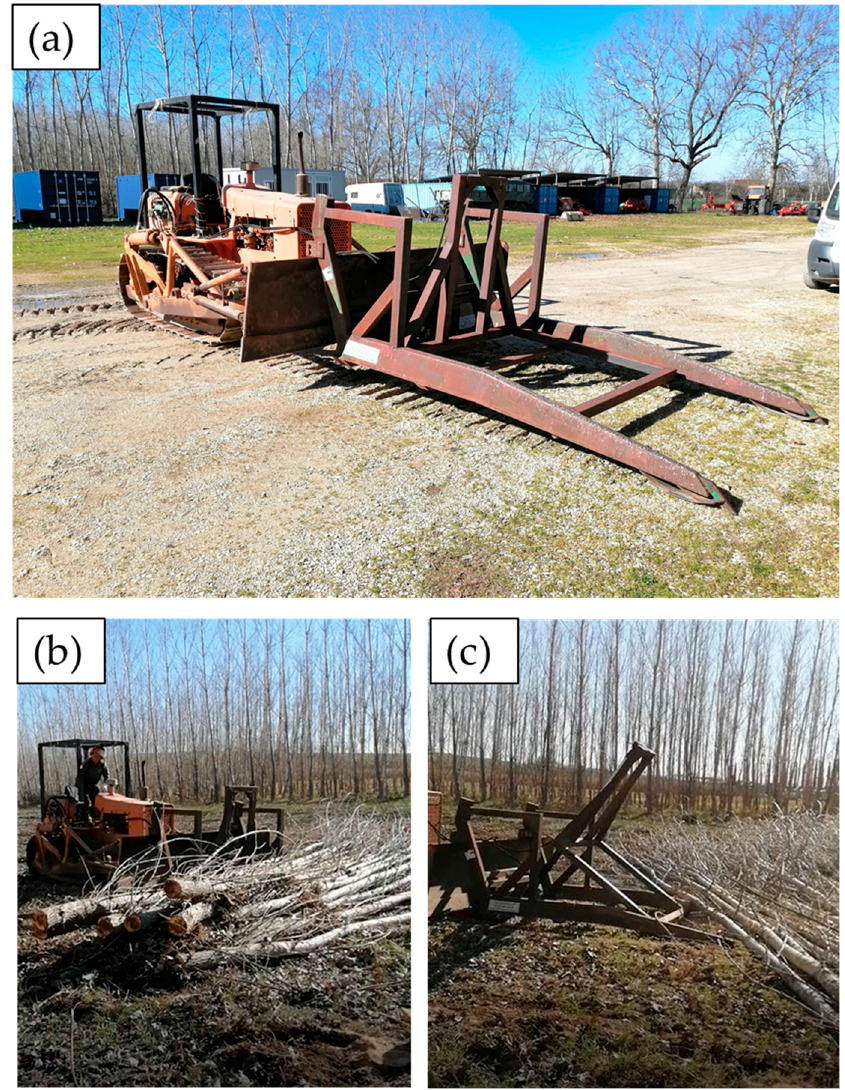
Figure 1. ( a ) Vision of CFL. ( b ) CFL while loading trees. ( c ) CFL while unloading